Question: How would you classify this visualization?
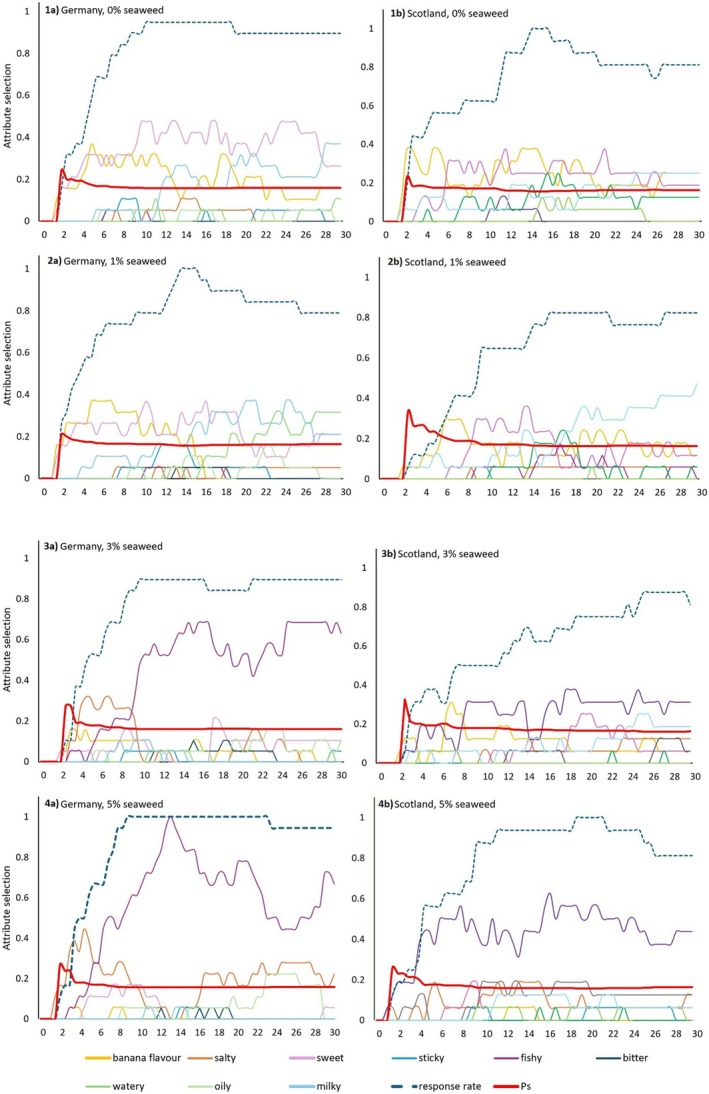
Answer: line